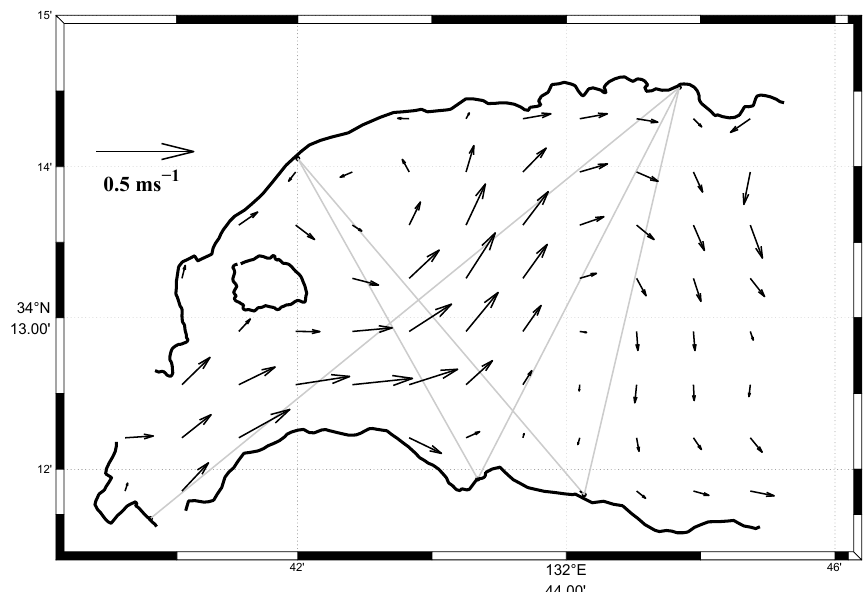
Figure 8. Distribution of the residual current calculated from April 4 to 5.